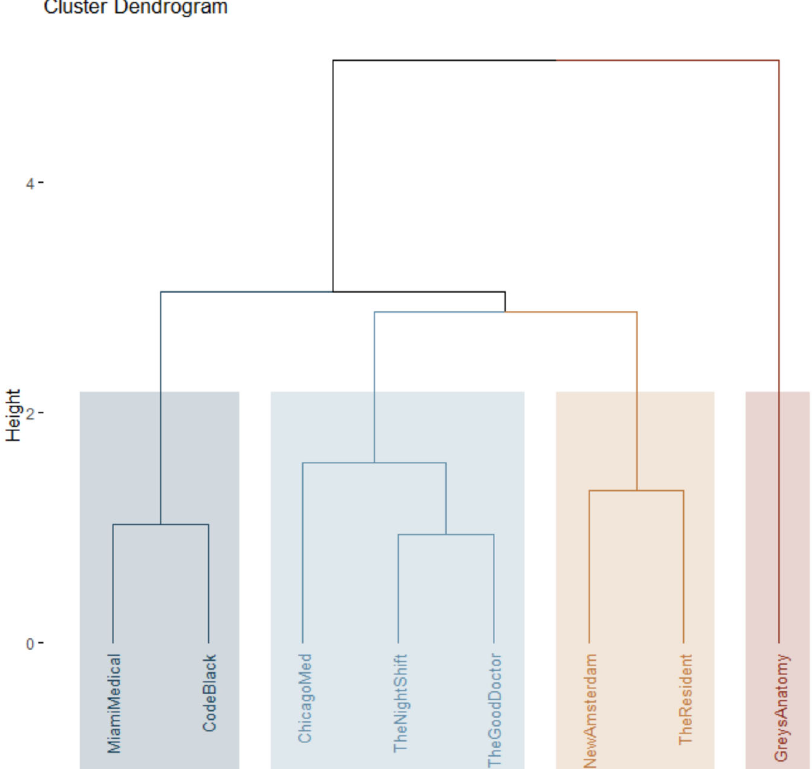
Fig. 3 Typical episodes: Hierarchical divisive clustering (DIANA). Clustering